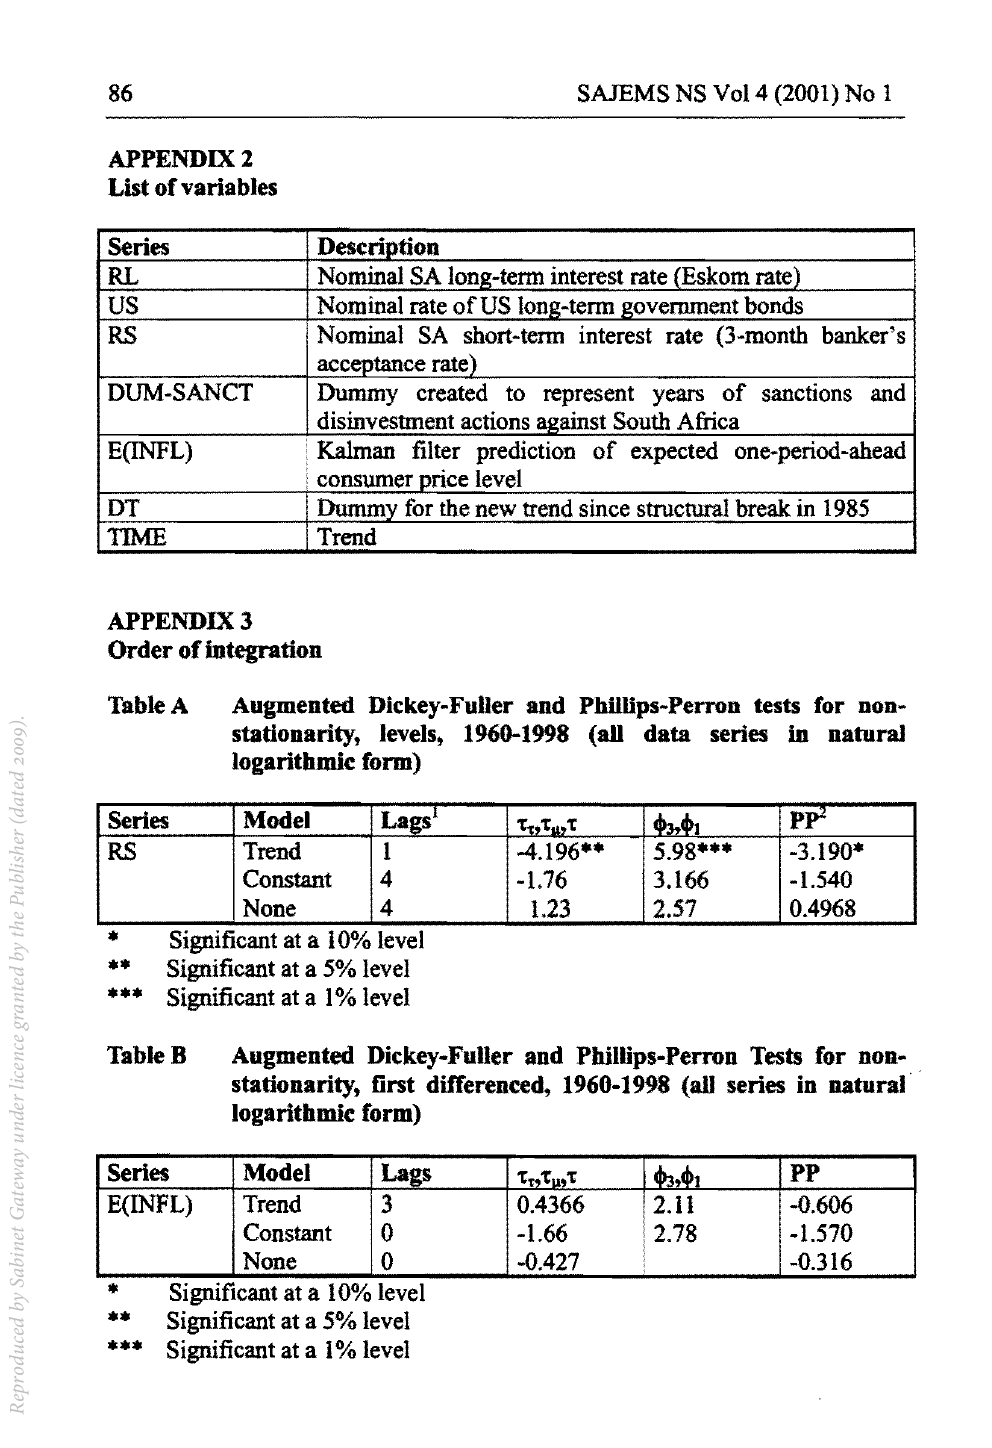
Augmented Dickey-Fuller and Pbillips-Perron Tests for non stationarity, first differenced, 1960-1998 (aU series in natural· logaritbmic